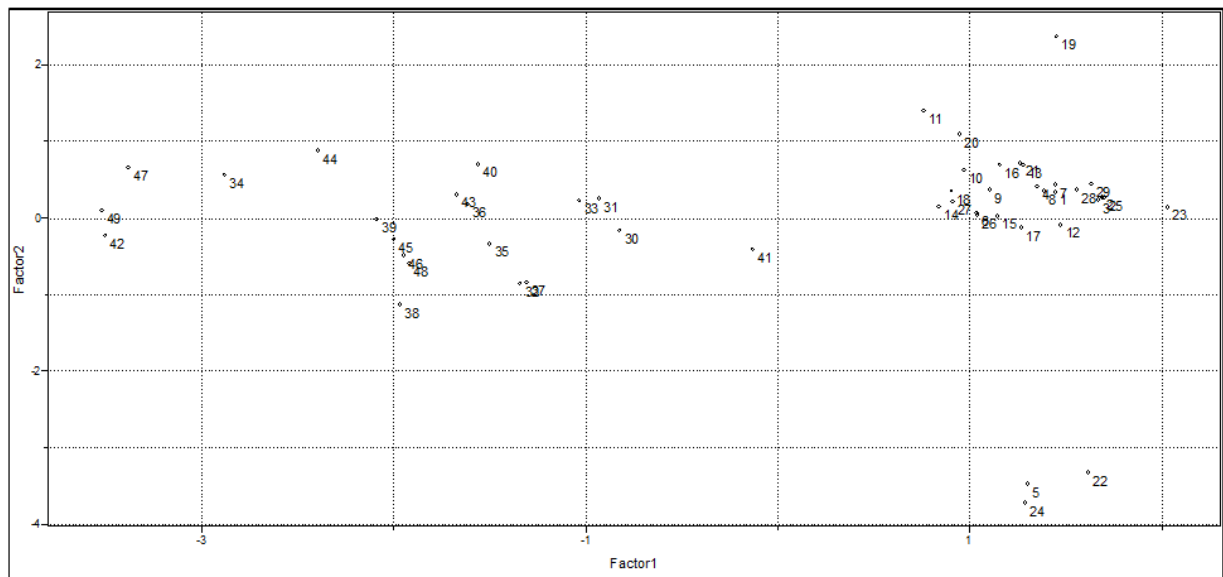
Figure 3. Scores plot of PC1 vs. PC2 for the 49 training set